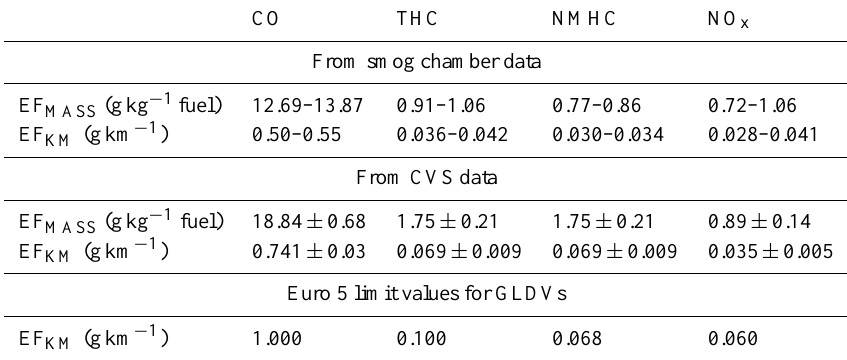
Table 3. Emission factors for regulated compounds calculated for a Euro 5 gasoline light-duty vehicle from smog chamber data and VELA (CVS) data, averaged over two experiments, and Euro 5 limit values for gasoline light-duty vehicles. For smog chamber data, the range of observed values, lowest–highest, is given.